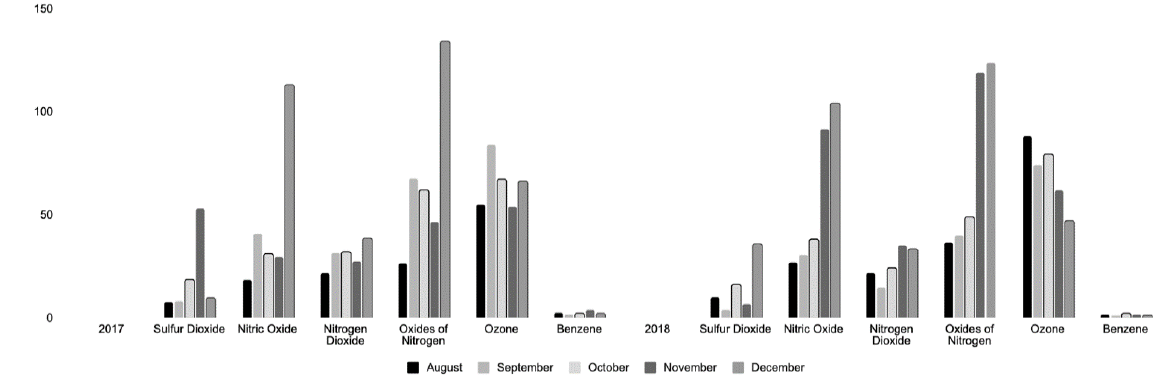
(MAX, all in ppb = 134.0, SD 14; 123.8, SD 14; CAP (in %) = 97.4, 88.4, respectively).